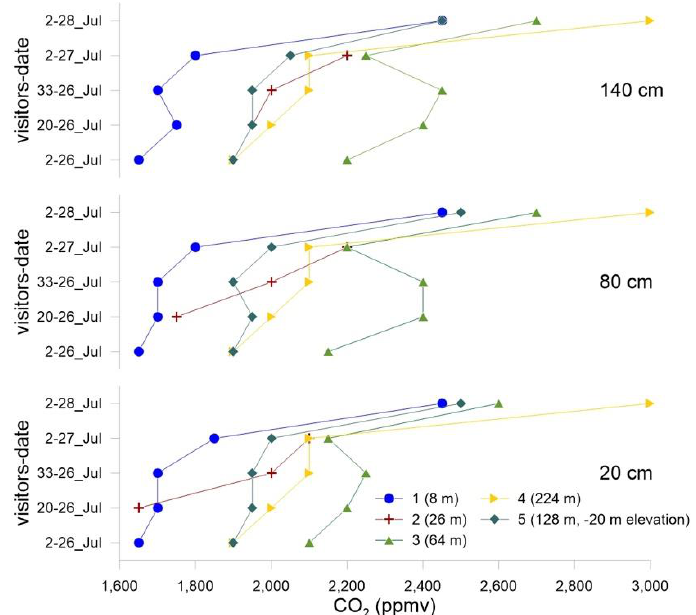
Figure 8. Air CO 2 concentrations measured inside Santa Ninfa cave during the 26–28 July 2000 experiment. Progressive distances of the points from cave entrance are reported between round brackets (see also Figure 3 for point locations).